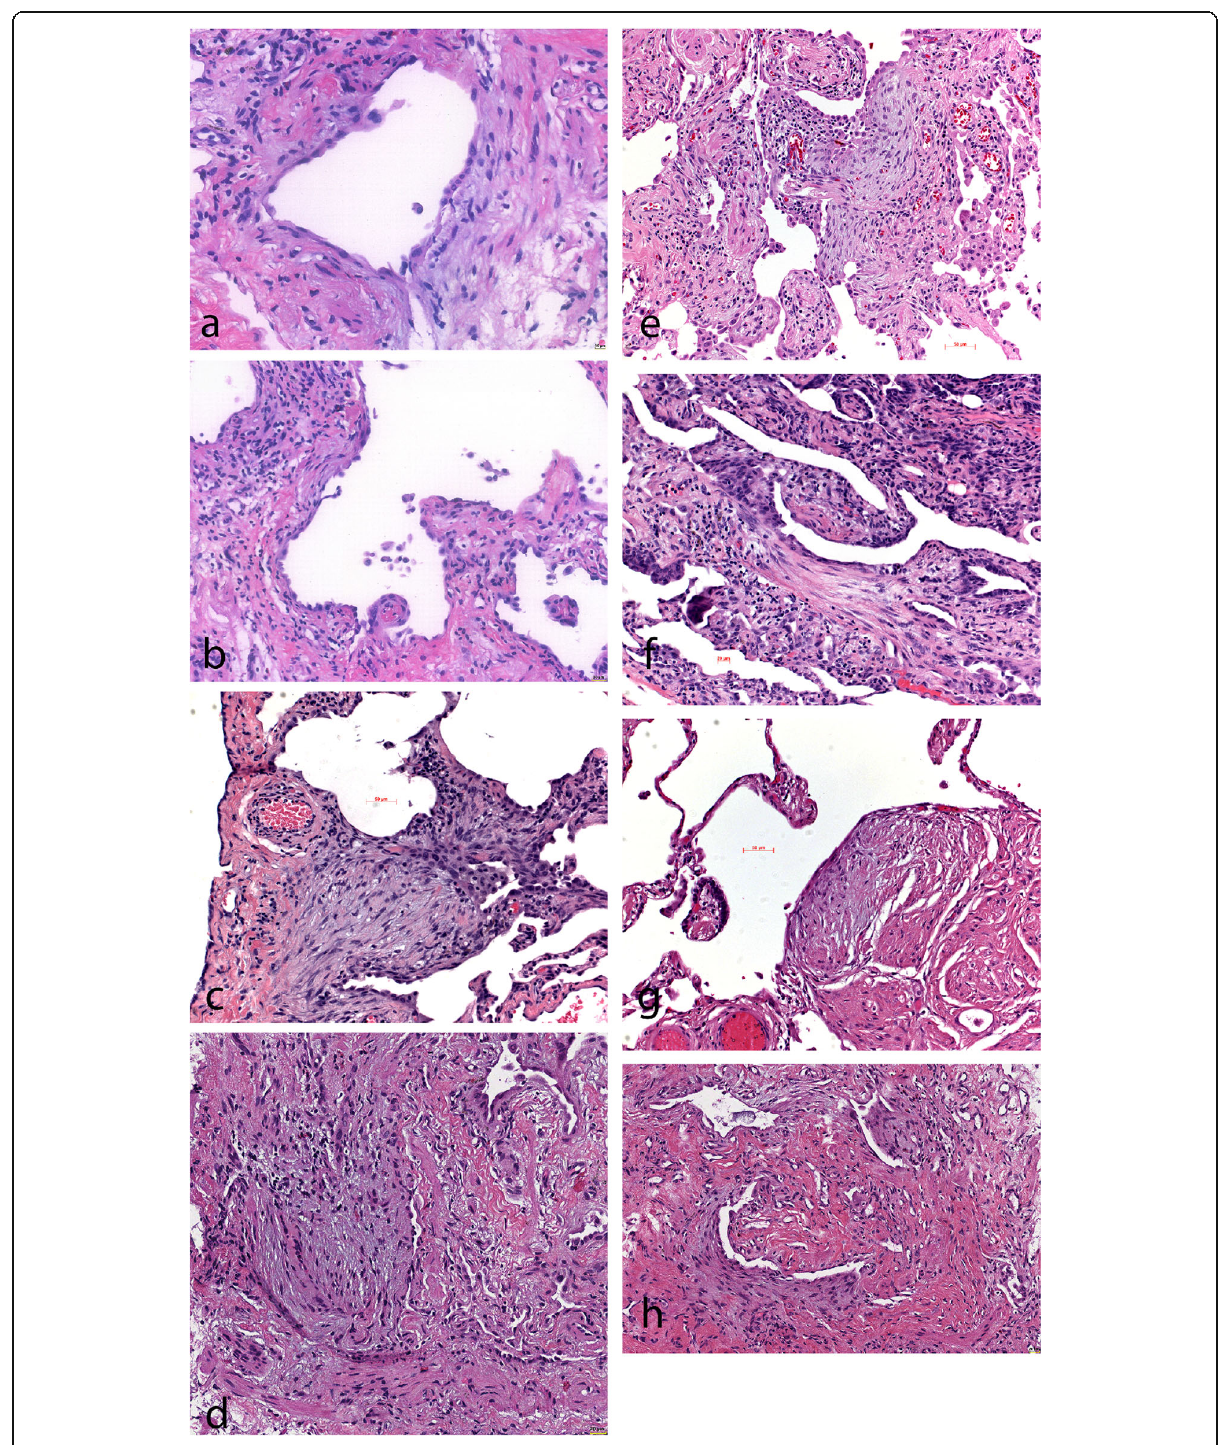
Fig. 4 Myofibroblastic foci at different age are shown; a ), b ), and c ) young myofibroblastic foci with few cells ( a and b ) and abundant myxoid matrix, in c ) more cellular lesion but still myxoid matrix; in e ) and f ) there is focal maturation of the myofibroblasts, characterized by an eosinophilic cytoplasm and collagen fibers; in h ) young and old myofibroblastic foci are side by side. This nicely demonstrate the development of these lesions, where the myofibroblasts change their phenotype and slowly acquire a more fibroblastic one. H&E, bars 50, 20, and 10 μ m,